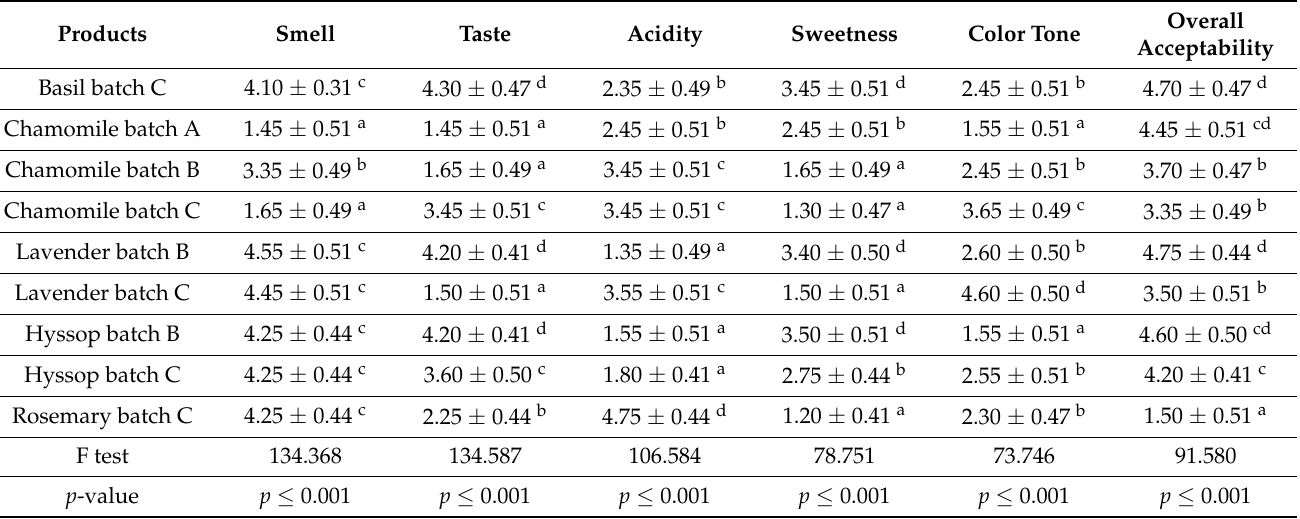
Table 6. Descriptive statistics table of sensory panel